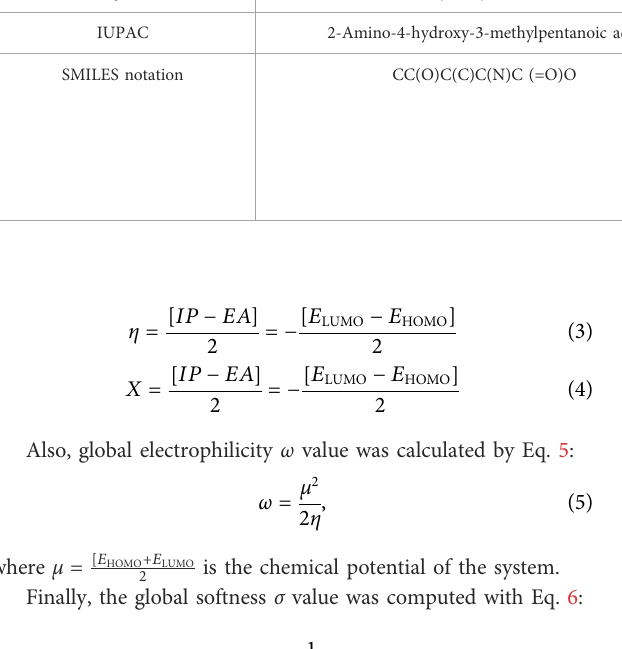
TABLE 1 Structure, IUPAC name, and SMILES notation of 4-hydroxyisoleucine. Ligand 4-Hydroxyisoleucine IUPAC 2-Amino-4-hydroxy-3-methylpentanoic acid SMILES